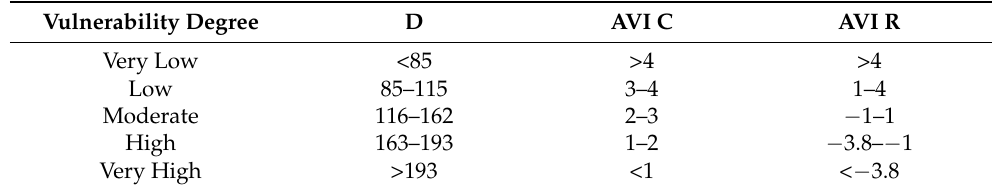
Table 1. Vulnerability degree as a function of the indexes of the vulnerability methods: DRASTIC (D), AVI Classic (AVI C), and AVI Reclassified (AVI